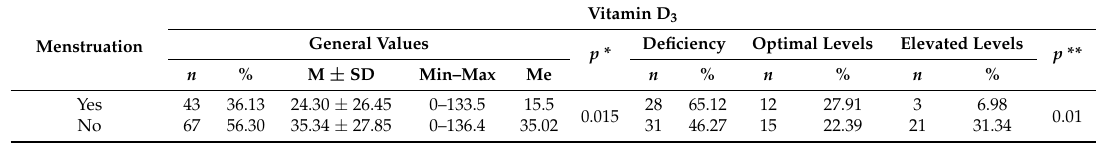
Table 6. Analysis of vitamin D 3 levels with regard to the women’s menstrual cycle. Vitamin D 3 General Values p * Deficiency Optimal Levels Elevated Menstruation